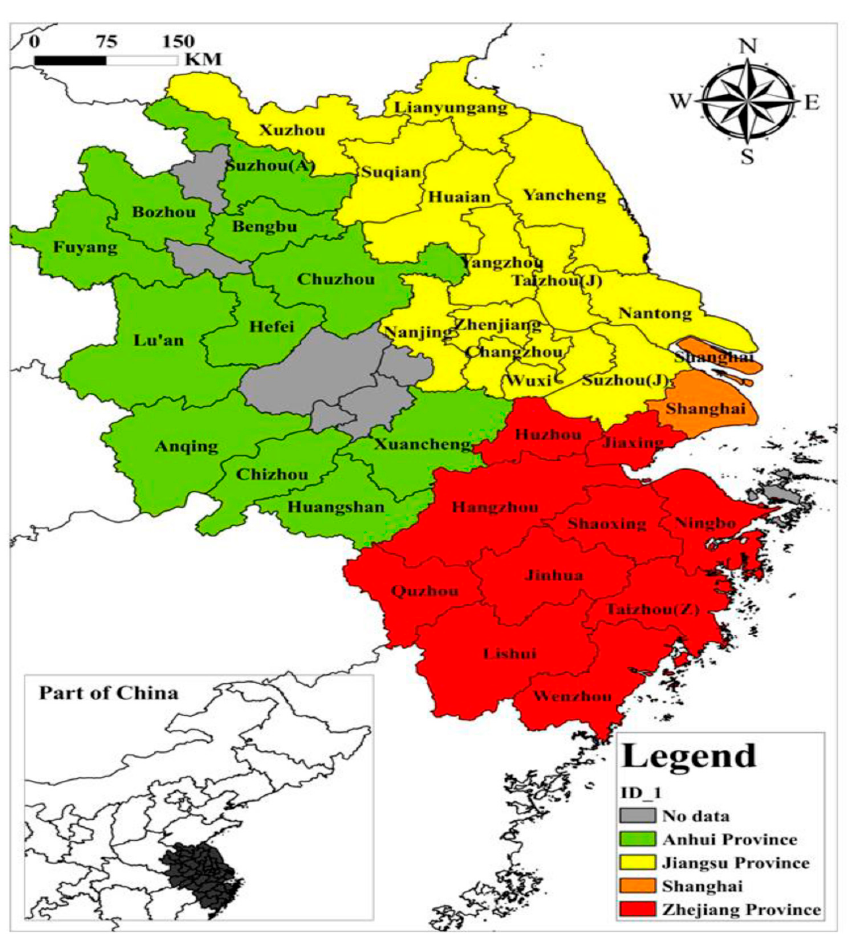
Figure 1. Study area showing the YRED.